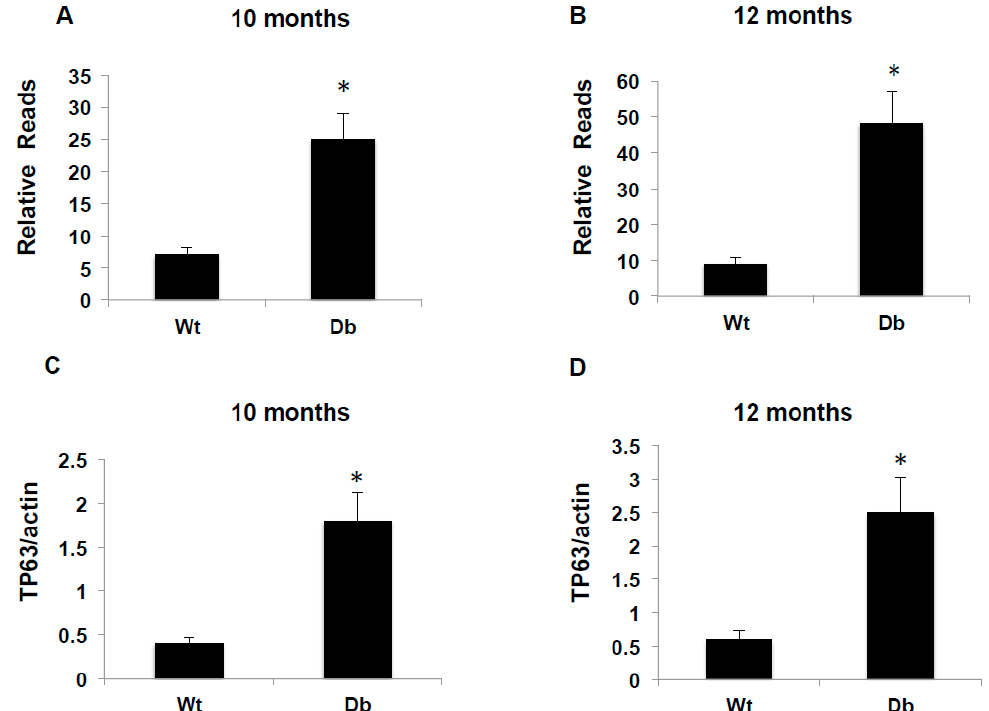
Figure 1. A Significant increase in RNA reads and tumor protein 63 (TP63) mRNA in diabetic mice. Kidney tissues from WT and diabetic mice were homogenized, and the total RNA was extracted. RNA reads were measured by RNA sequence in 10-month-old ( A ) and 12-month-old ( B ) mice. ( C , D ) mRNA of TP63 quantitation was performed by qRTPCR showed higher expression in diabetic mice compared to WT mice. A significant difference from WT mice is indicated by * p < 0.01.